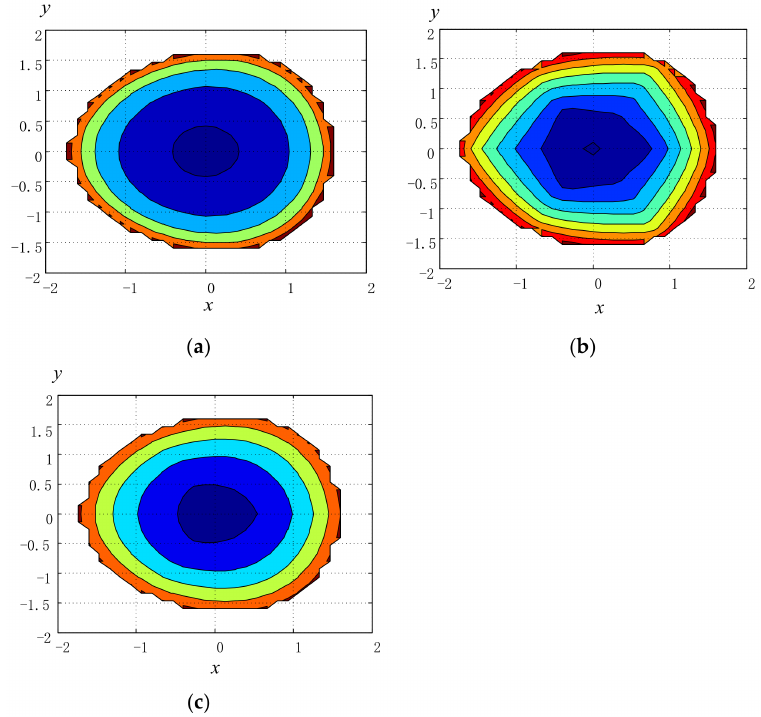
Figure 8. Contours of κ and of the maximum ITA and CTA in bounded workspace. ( a ) Contours of κ ;